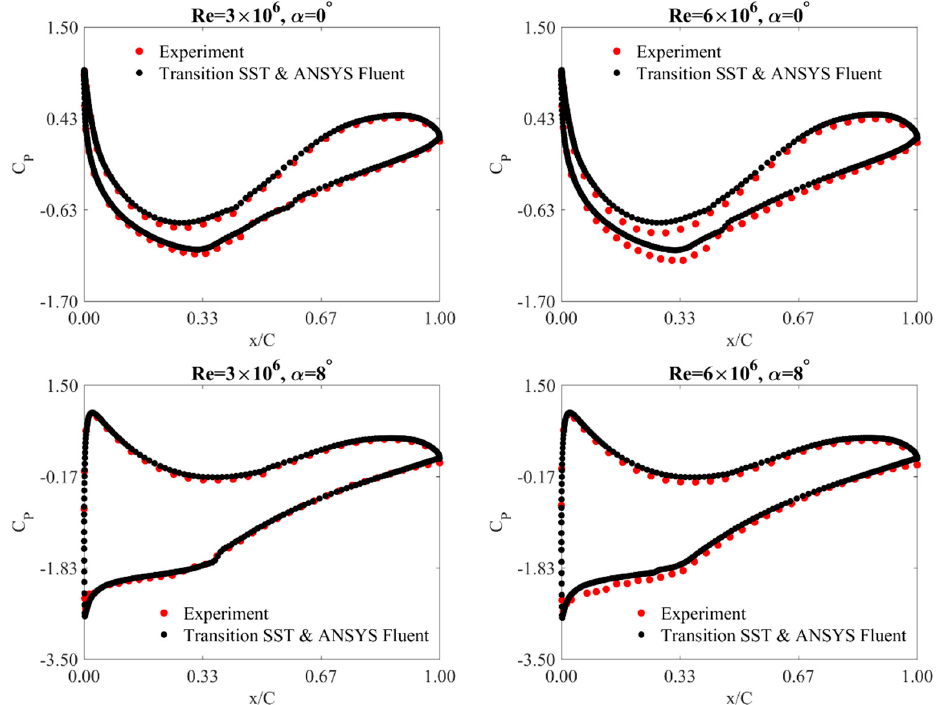
Figure 8. Static pressure distributions calculated for different angles of attack and for different Reynolds numbers.